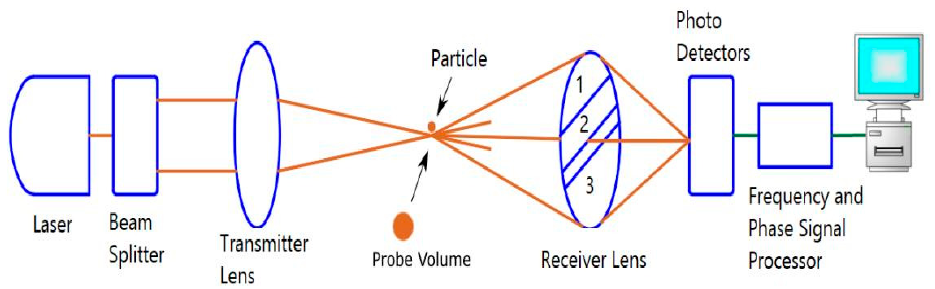
Figure 4. Schematic of a phase Doppler anemometer system making use of two coherent laser lights that are emitted from two beams and intersect at a specific angle to form a measuring volume. The droplet size is measured by analyzing the difference between two bursts detected using different detectors in a different angle, while the velocity is determined by analyzing the Doppler-equivalent frequency of the scattered light through the droplet [101,102].